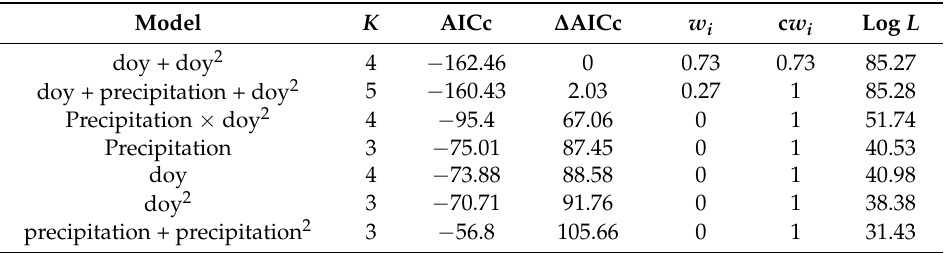
Table comparing the fixed effects of a priori models of butterfly community composition (NMDS 1). K = number of parameters in the model, w i = Akaike weights, c w i = cumulative Akaike weights, and log L = log likelihood. Model parameters: “doy” is the day of year, and “precipitation” is the total precipitation in the 60 days prior to the sample bout. Fixed effect model structure was determined first, and random effect model structure was determined afterward (Table 2). Parameter estimates for the best fit model are found in the